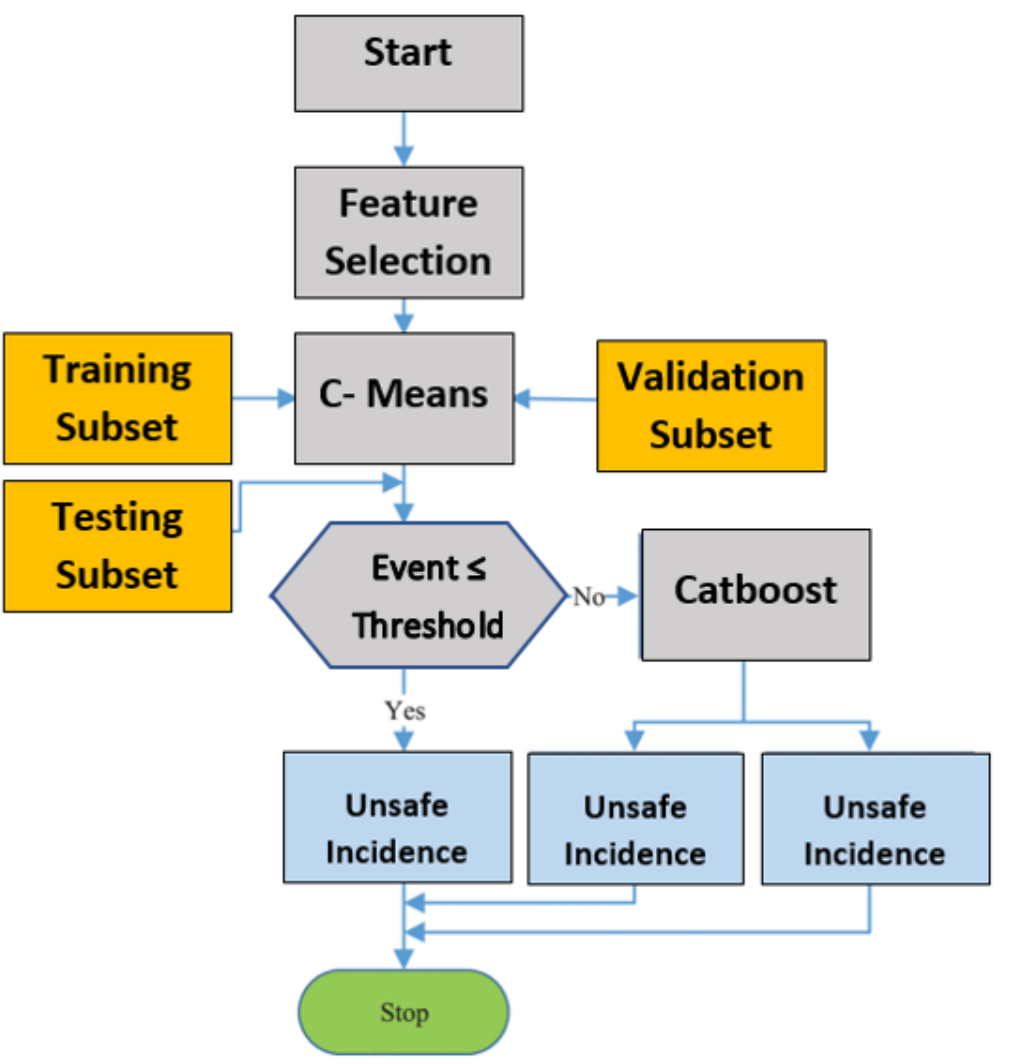
Figure 6. The model platform of the C-means and the Catboost techniques. The model depicts the training and testing set to produce the different safe and fall classes.